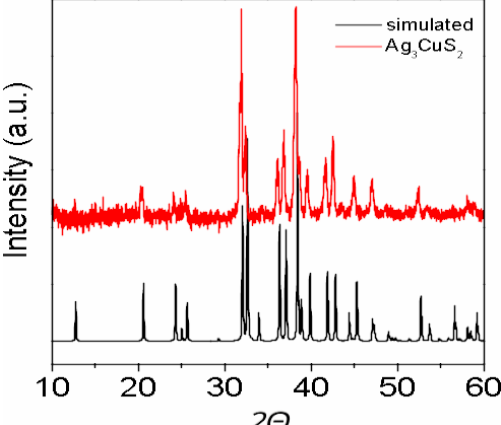
Figure 2. X-ray experimental diffraction pattern of Ag 3 CuS 2 and simulated X-ray diffraction of I4 1 /amd